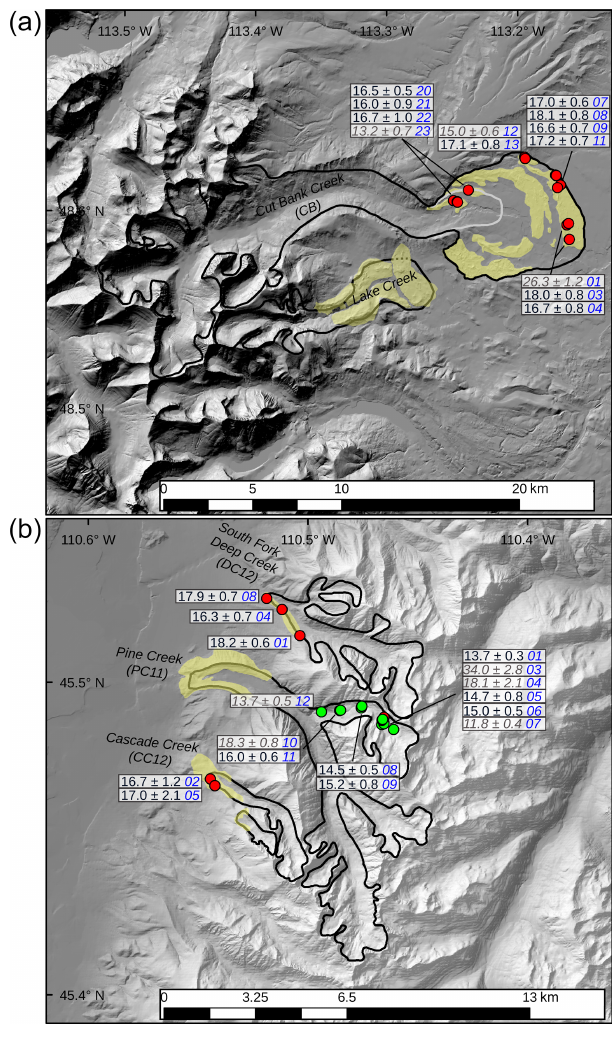
Figure 2. (a) Cut Bank Creek study area located in the Lewis Range of northern Montana. (b) Northern Absaroka Range study area including South Fork Deep Creek, Pine Creek, and Cascade Creek drainages. Pinedale maximum ice extents are outlined in black (dashed where inferred). The recessional position at Cut Bank is outlined in light grey. Moraine deposits are shown in yellow, and cosmogenic 10 Be boulder and bedrock sample locations are indi- cated by red and green circles, respectively, with exposure ages (Promontory Point calibration data and LSD scaling scheme) and analytical uncertainty (shown in ka); sample codes are in blue text. Exposure ages interpreted as outliers are shown in grey and itali-